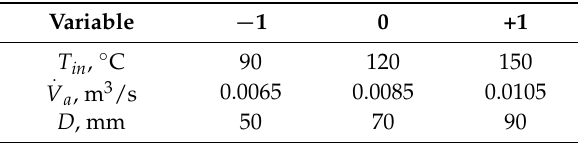
Table 1. Assumed values of input factors.